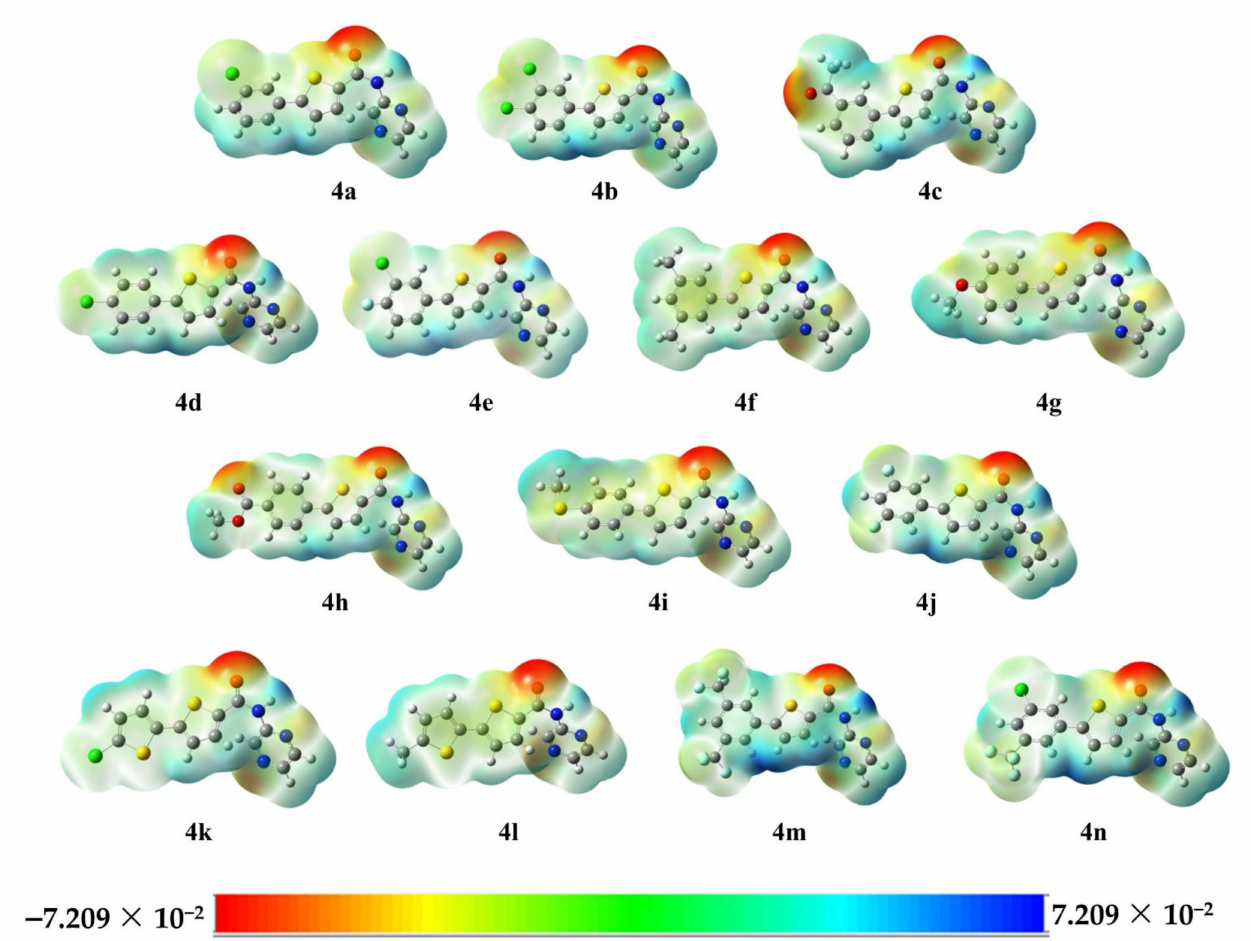
Figure 5. Molecular electrostatic potential surfaces of the final compounds 4a – 4n computed at the PBE0-D3BJ/def2- TZVP/SMD 1,4-dioxane level of theory. The units for the scale are atomic